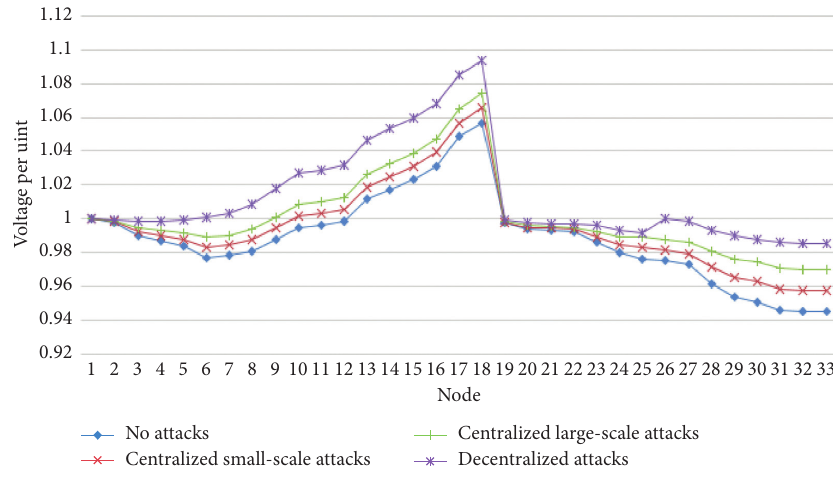
Figure 10: The voltage value of nodes before and after A II